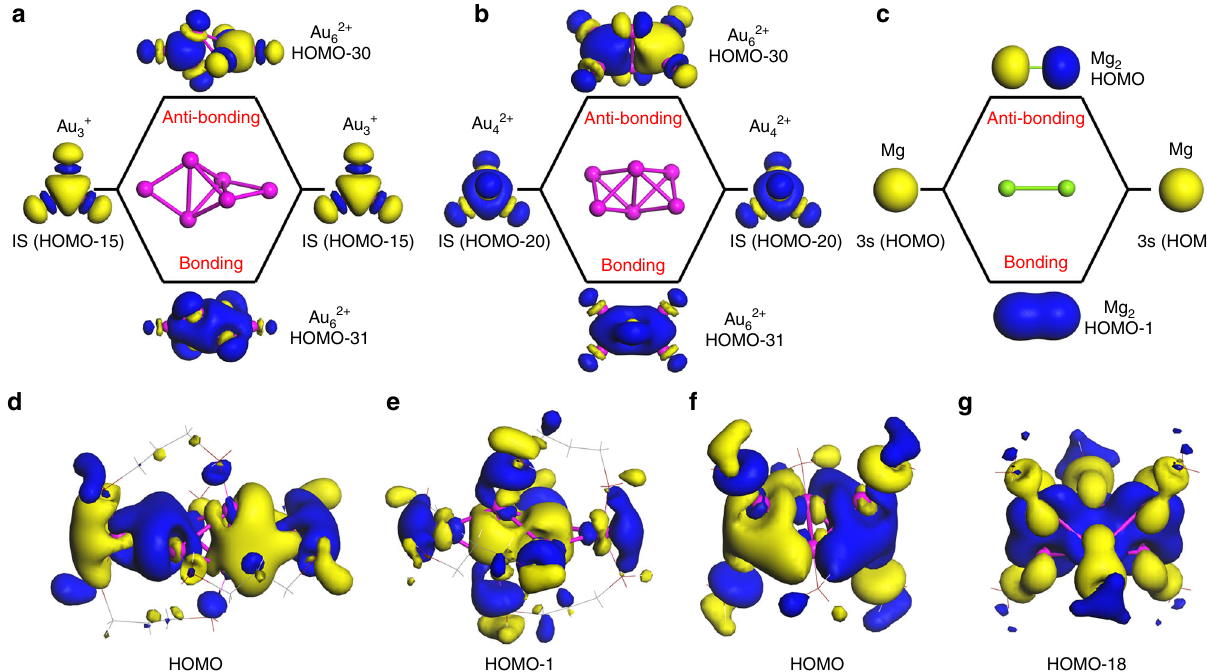
Fig. 2 The anti-bonding and bonding orbital diagrams of clusters. a D 2 d Au 6 2+ , b D 2 h Au 6 2+ , and c Mg 2 . The HOMO d and HOMO-1 e of [Au 6 (dppp) 4 ] 2+ , HOMO f , and HOMO-18 g of [Au 6 (PR 3 ) 6 ] 2+ . Color code: Au — magenta, Mg —